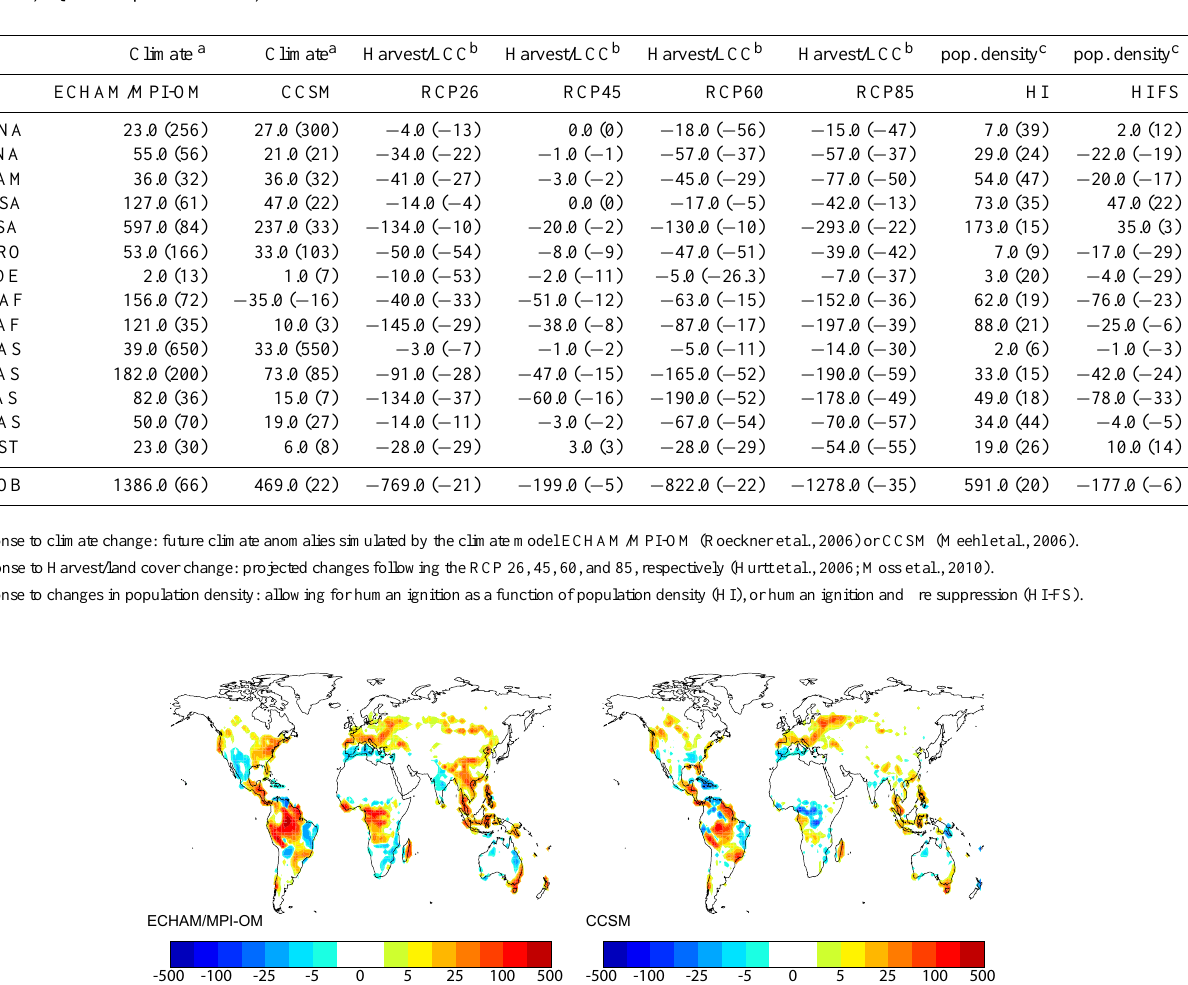
Table 2. Changes in global annual mean fire emissions caused by different forcings agents averaged over the period 2075–2099 [Tg Cyr − 1 ]. Number in brackets are changes in percentage. Simulations with transient varying forcings were compared to a control simulation in which the forcing was kept constant at preindustrial level. The difference in percentage was calculated relative to the control simulation. Regions used in this study were identical to the one defined in van der Werf et al. (2006): BONA: Boreal North America, TENA: Temperate